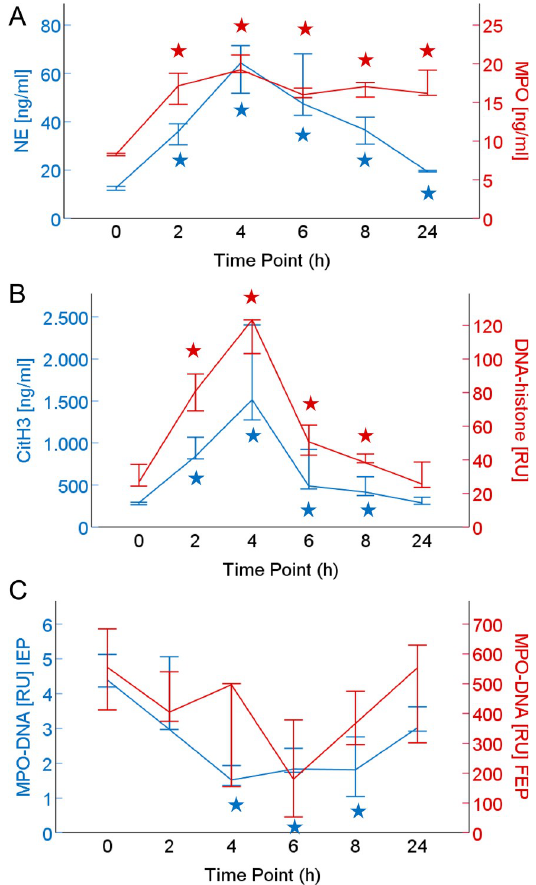
Fig 9. Levels of MPO-DNA complexes and parameters of neutrophil activation and NET formation in plasma samples of an experimental endotoxemia model. Blood of seven healthy volunteers was sampled at baseline (0 h) and at various time points after LPS infusion. Plasma was assessed for A) NE and MPO, B) citH3 and DNA-histone complexes and C) MPO-DNA complexes according to the initial (IEP) and the final ELISA protocol (FEP), both with isotype signals deducted before calculation of relative units (RU). Median values and their 50% confidence intervals are indicated. $ p < 0.05 according to Wilcoxon signed-rank test (in comparison to